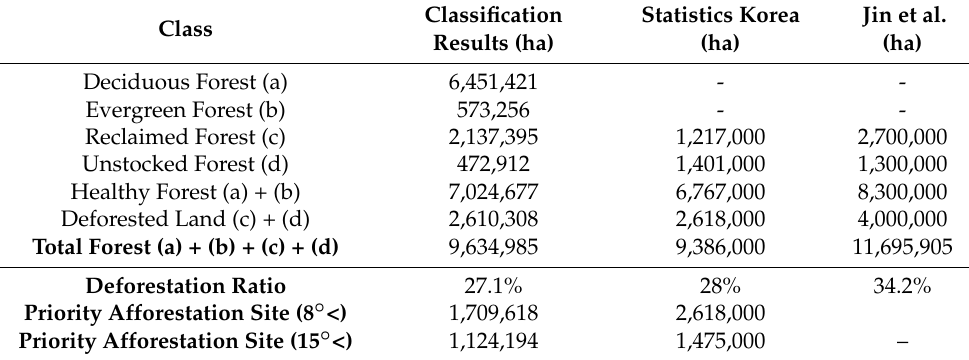
Table 4. Result comparison of deforestation